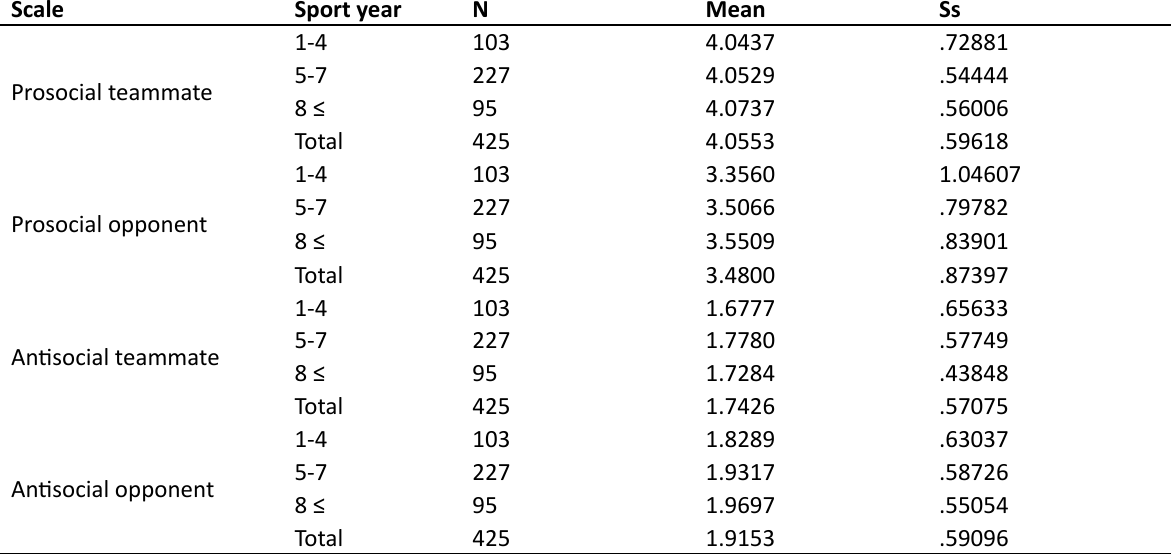
Table 1. Results of prosocial and antisocial behaviors of athletes (sports year, mean, standard deviation) Scale